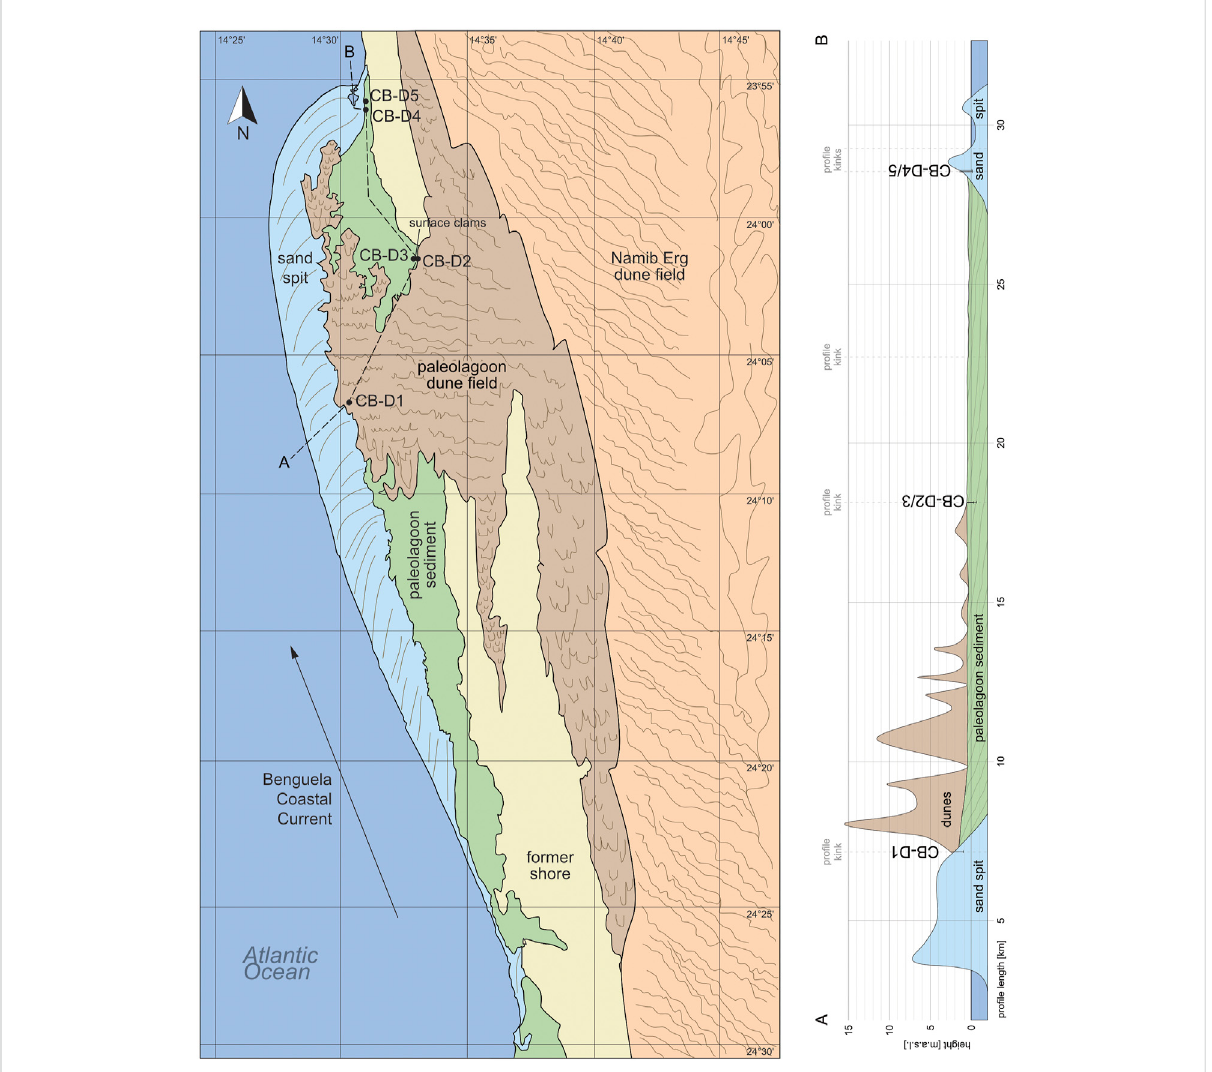
FIGURE 8 Sedimentological map and pro fi le A-B of the basic sedimentary units in the Conception Bay paleolagoon area with locations of the sediment cores.Remotesensing mappingon thebasis ofvarioussatellite images provided by Google Earth(ImageLandsat/Copernicus). Validation byfollow- up ground